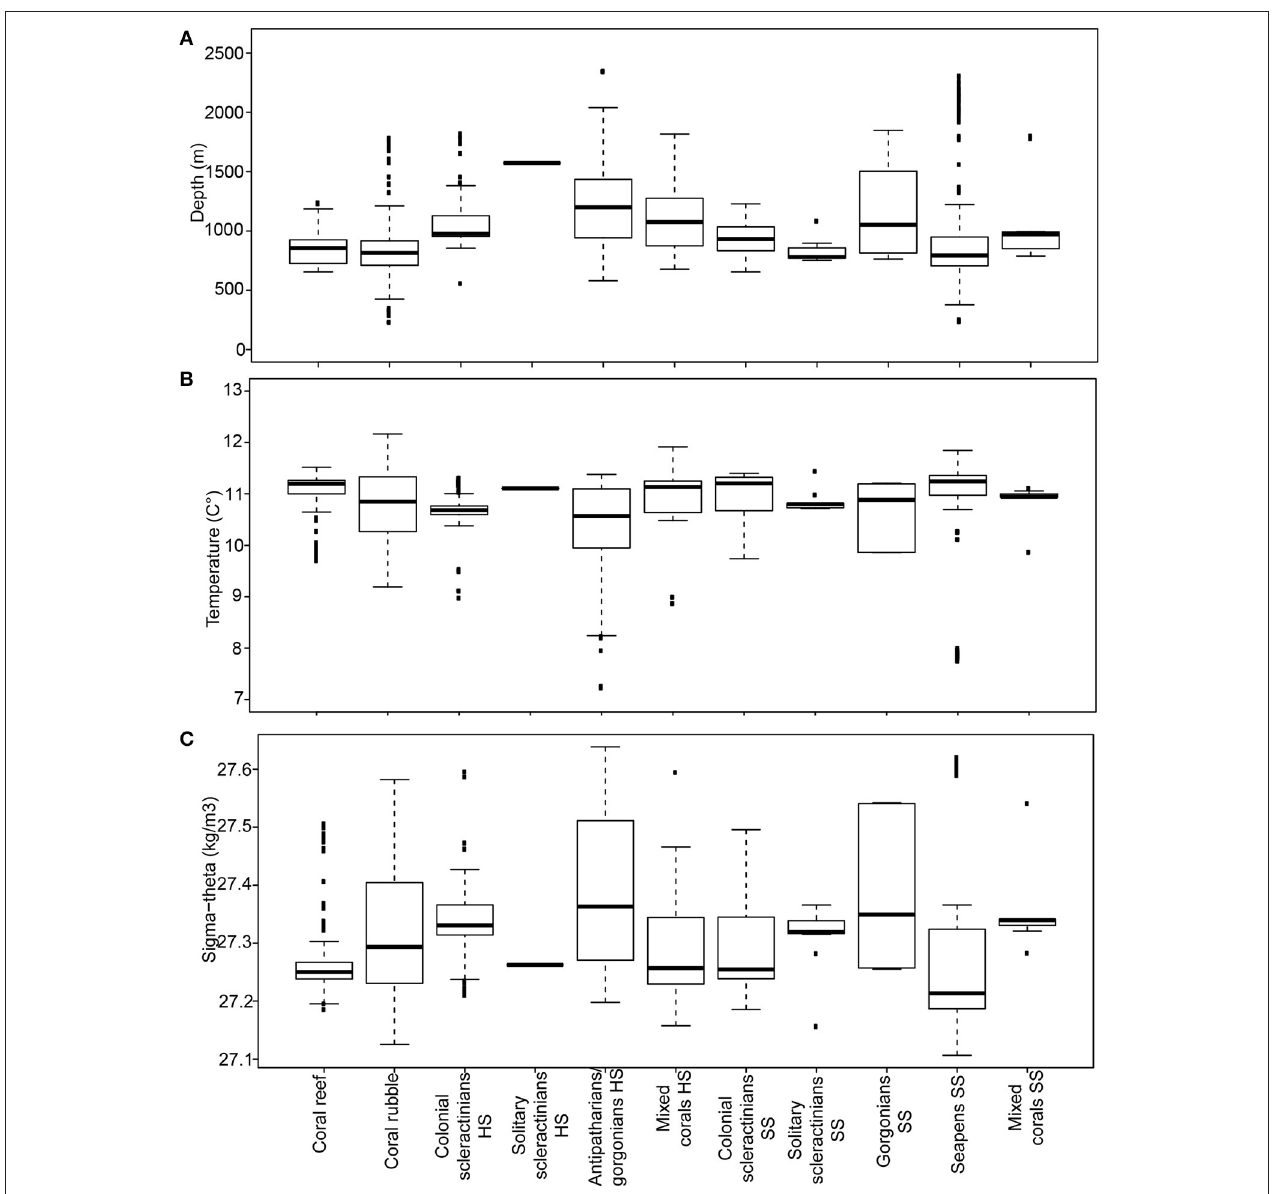
FIGURE 8 | Boxplots of (A) depth, (B) temperature, (C) water density (sigma-theta) for the 11 coral habitats observed in the Bay of